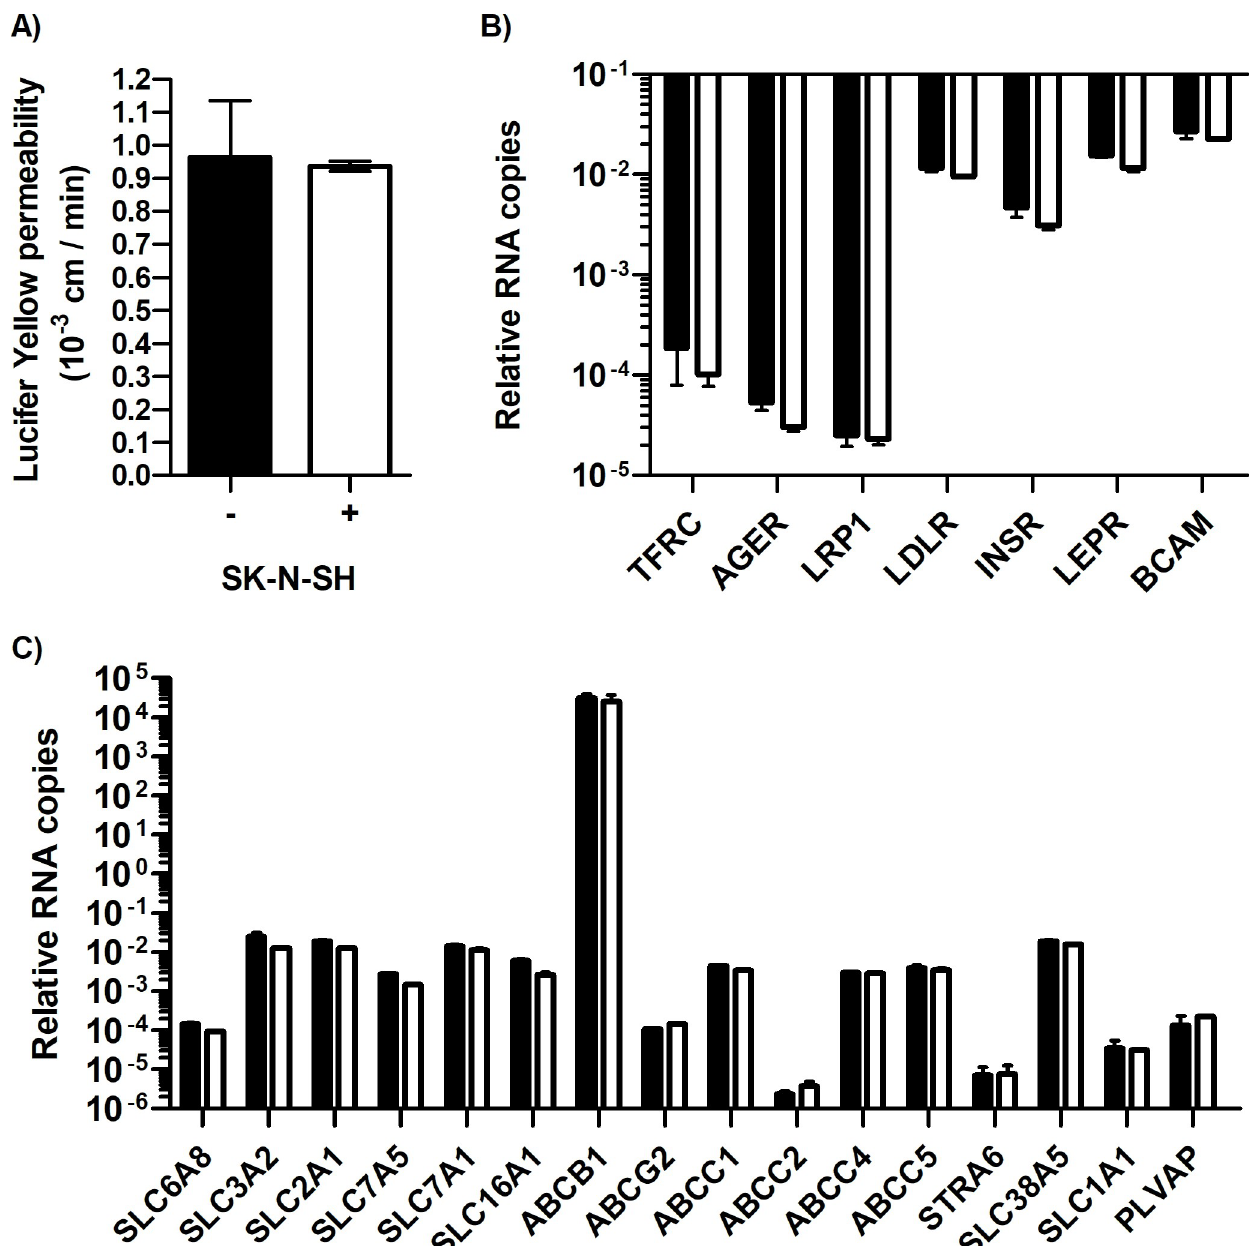
Fig 1. SK-N-SH cells do not affect hCMEC/D3 BBB properties. hCMEC/D3 were cultivated on Transwell 1 inserts. Five days after seeding, SK-N-SH (SK) cells were cultivated or not in wells under the Transwell 1 inserts (white and black bars respectively). A) Twenty-four hours after adding the SK-N-SH cells (+) or not (-), BBB permeability to LY was measured. B) and C) hCMEC/D3 BBB total RNA was extracted and expression of receptor (B) and transporter (C) genes typical of the BBB- encoding genes were quantified by RT followed by qPCR as described in Material and Methods. Graphs show the results from two independent experiments performed in